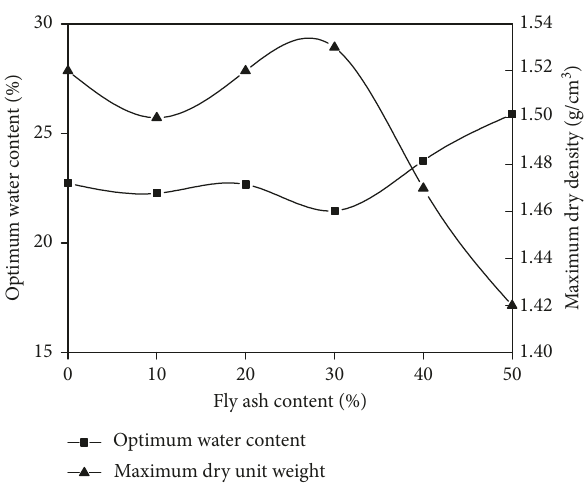
Figure 3: Variations of the optimum water content and maximum dry density of fly ash-soil mixtures.